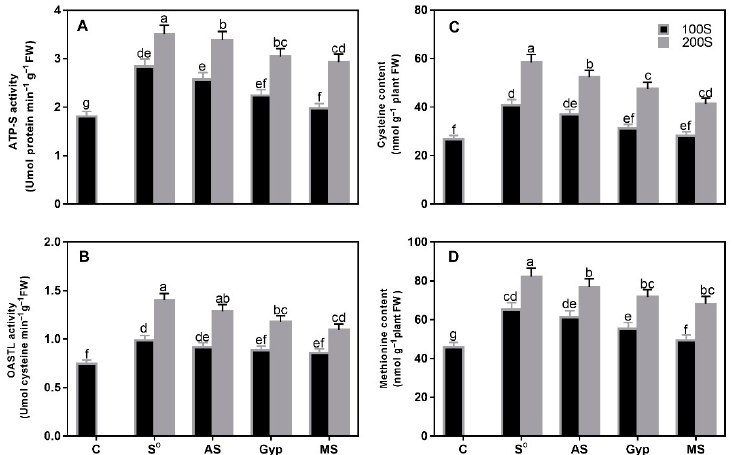
Figure 1. Foliar ( A ) Cysteine content, ( B ) Methonine content, ( C ) ATP-S activity, and ( D ) OASTL activity in Brassica juncea cv. Giriraj treated with elemental S (S 0 ), ammonium sulfate (AS), gypsum (Gyp) or magnesium sulfate (MS), under two S levels (100 and 200 mg S kg − 1 ). Data are presented as means ± SE ( n = 4). Data with the same letter are not significantly different by LSD test at p < 0.05. ATP-S, ATP sulfurylase; C, control; FW, fresh weight; OASTL, O-acetylserine (thiol) lyase. Photosynthetic and growth parameters were positively influenced by both S levels (100S and 200S). In contrast to 100S, the effects of 200S on growth and photosynthetic at- tributes were more conspicuous for all S sources. Among the four sources of S used, S 0 showed a more protruding effect than any other S source, both at 100 and 200S levels, and generally increased the values of growth and photosynthetic parameters. The entity of the effect of S 0 was followed by those of AS, Gyp, and MS. S 0 -treated plants had increased chlorophyll content, net photosynthesis, intercellular CO 2 concentration, stomatal con- ductance and maximal PSII efficiency, plant fresh, and dry biomass, particularly at 200S. The increases in these characteristics were by 48.9, 37.7, 75.2, 70.9, 35.2, 40.1, and 86.3%, respectively, compared to the control (Table 3). Of the two S levels, 200S was more efficacious in increasing the activity of ATP-S and OASTL by 93.3 and 87.8% (S 0 ), 86.7 and 73.0% (AS), 67.9 and 58.1% (Gyp), and 61.9 and 47.9% (MS), respectively, over the control (Figure 1A,B). A similar trend was observed for Cys and Met content, where 200S caused increased Cys content by two-times and Met content by 79.1%, in respect to the control (Figure 1C,D). The higher effectiveness of 200S improved plant growth more than 100S. For this reason, 200S treatment was considered for further study.